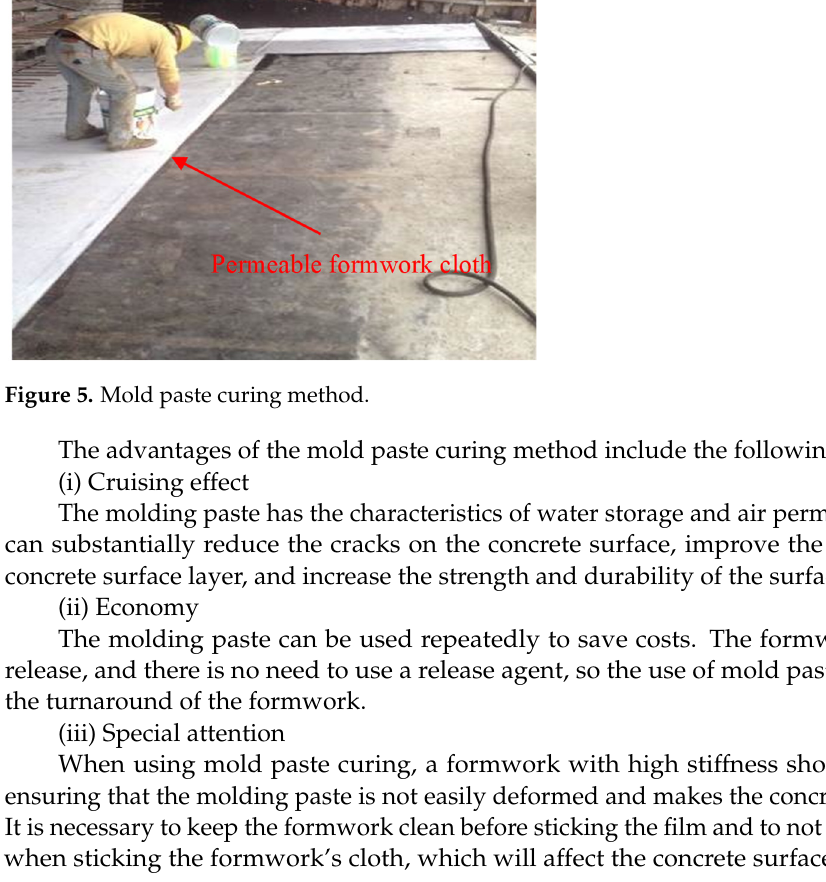
Figure 5. Mold paste curing method.